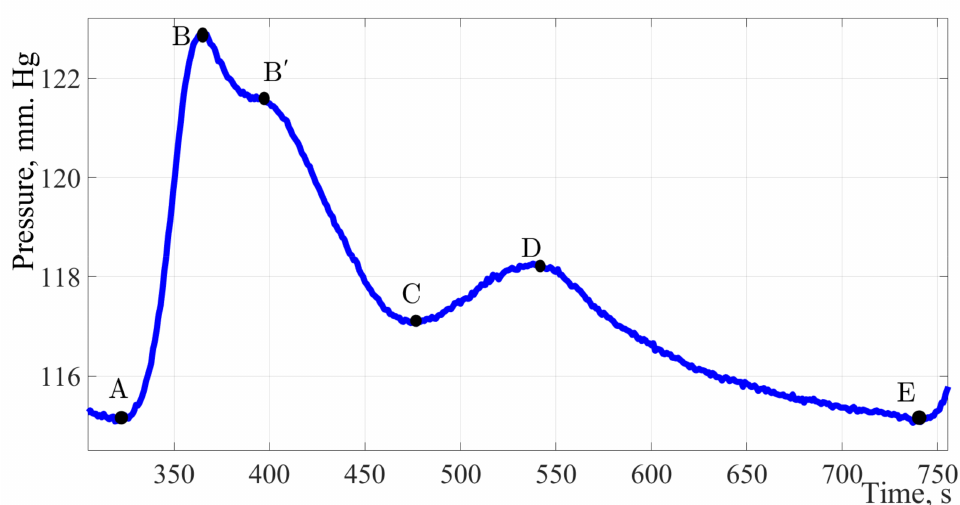
Figure 5. The pulse wave signal fragment of a 20-year-old young men without identified pathologies. Considering the fragment of the pulse wave of a twenty-year-old patient, it can be noted, in addition to the classical peaks, a characteristic sub-lash is marked on contour B (cid:48) on the segment of the curve from point B to point